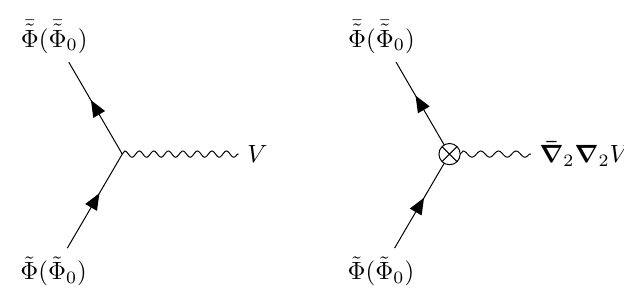
Figure 8 . Three-point vertices arising from the interaction terms of the SGED action, eq. (5.22). While the left vertex is the covariantized version of the original one, the right one is genuinely